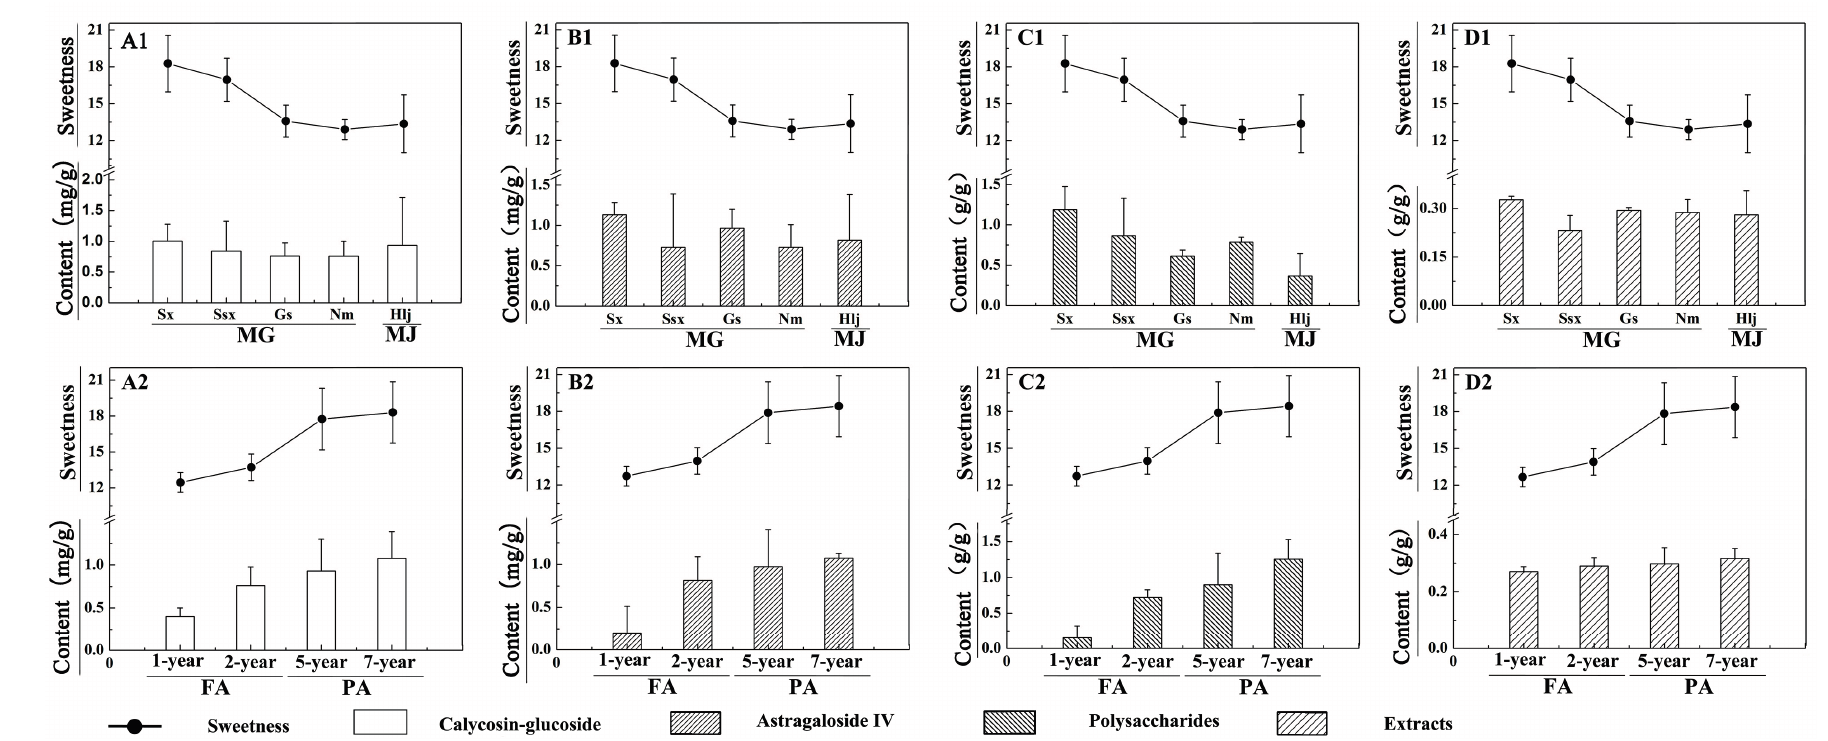
Figure 2. Contents of calycosin-glucoside, astragaloside IV, total polysaccharides and extracts in RA samples and RA sweetness levels across different species, regions, and growth years. Sweetness indicates relative sweetness of RA with the sweetness of 10% sucrose solution considered to be 1.0; The contents of calycosin-glucoside (mg/g), astragaloside IV (mg/g), total polysaccharides (g/g) and extracts (g/g) of RA are shown in Figure A1, A2, B1, B2, C1, C2, and D1, D2, respectively; MG ( A. membranaceus var. Mongholicus (Bge.)) and MJ ( A. membranaceus (Fisch.) Bge.) represent the two species of RA; FA (fast-growing RA (1–2 years samples)) and PA (perennial RA (5–7 years samples)) represent the two different growth years of RA; Sx (Shanxi province), Ssx (Shaanxi province), Gs (Gansu province), Nm (Inner Mongolia), and Hlj (Heilongjiang province) represent the five regions of